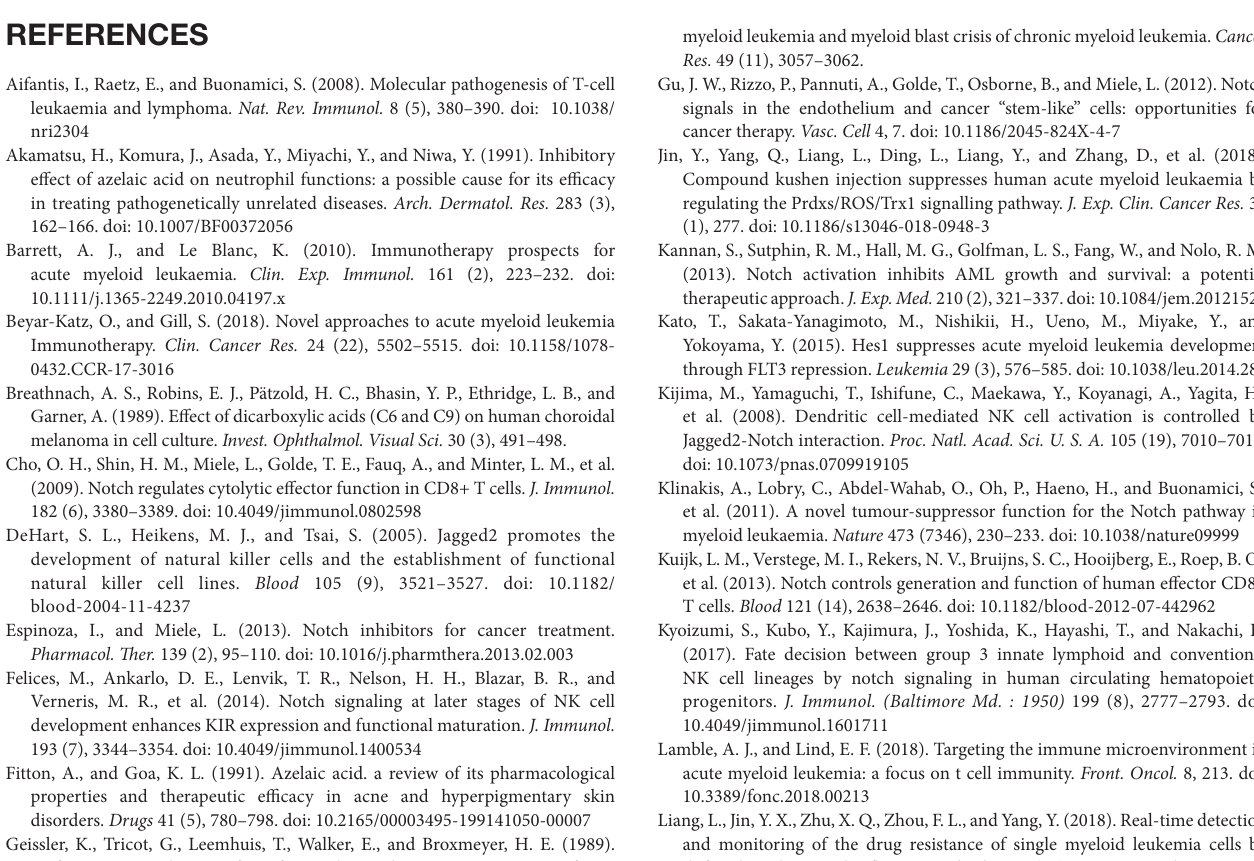
FIgUrE S1 | The excitation wavelength and emission wavelength of BDP-AZA. FIgUrE S2 | The interaction between Notch and other proteins was analyzed by STRING. FIgUrE S3 | (A) Analysis of peripheral blood smear after the injection of C1498 cells. (B) The mice in saline group displayed trichomadesis in compared to AZA group. (c) Analysis of spleen HE staining after AZA treatment. (D) Mouse MNCs were stained with CD3, CD4 and CD8 for flow cytometric